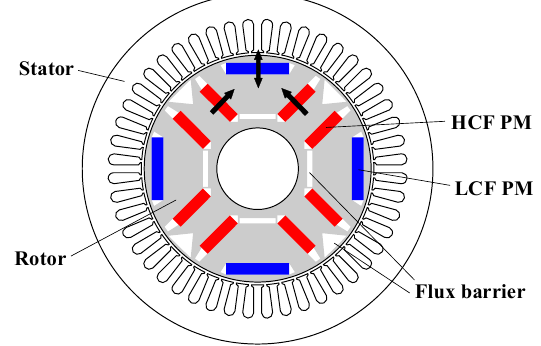
Figure 33. Double ‐ layer hybrid PM VFM machine [86].